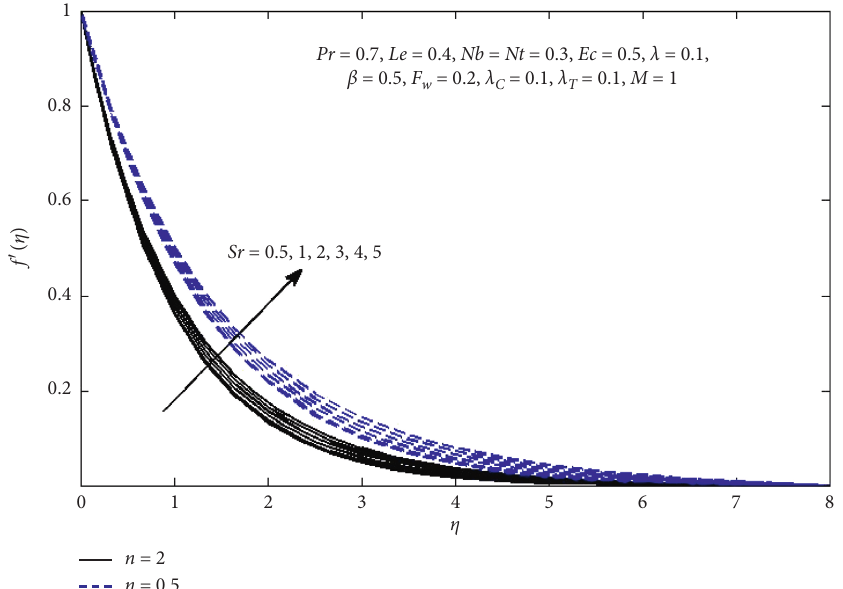
Figure 17: Variation of velocity f ′ concerning η with various values of Sr ( n � 2 __, n � 0.5 ---).